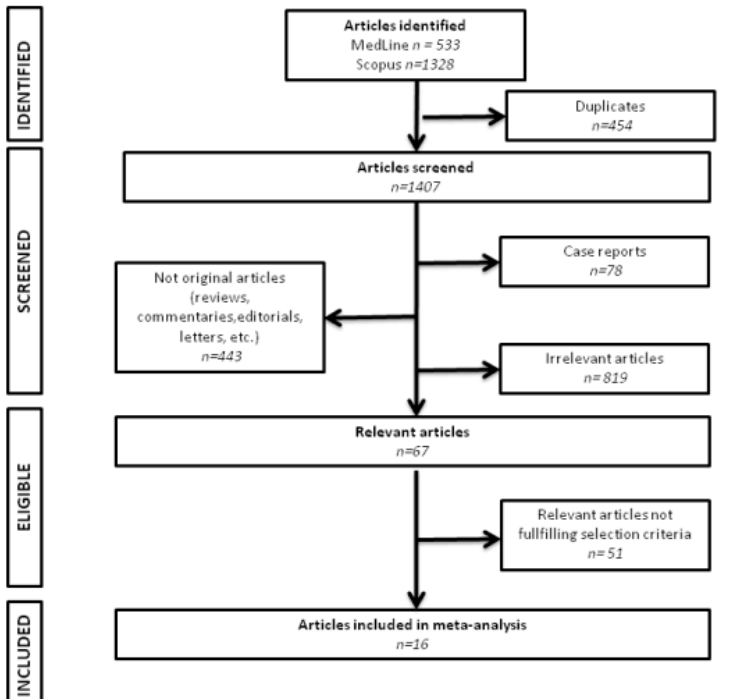
Figure 1. Flow of study selection.